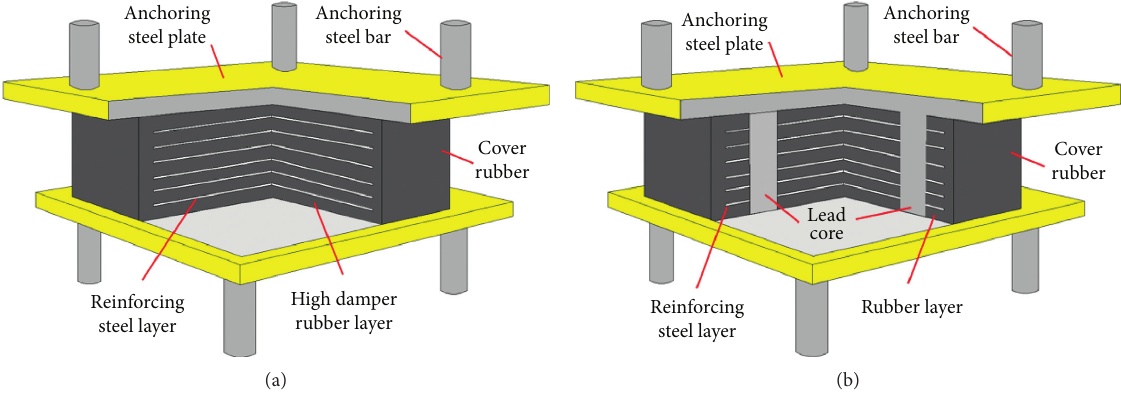
Figure 1: Structural composition of isolation bearings: (a) HDRB; (b)